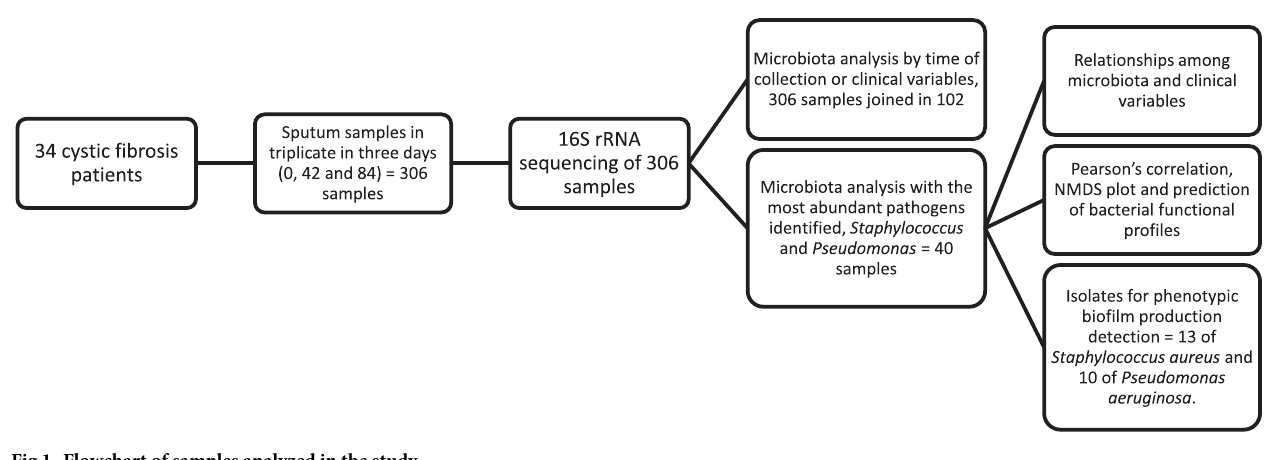
Fig 1. Flowchart of samples analyzed in the